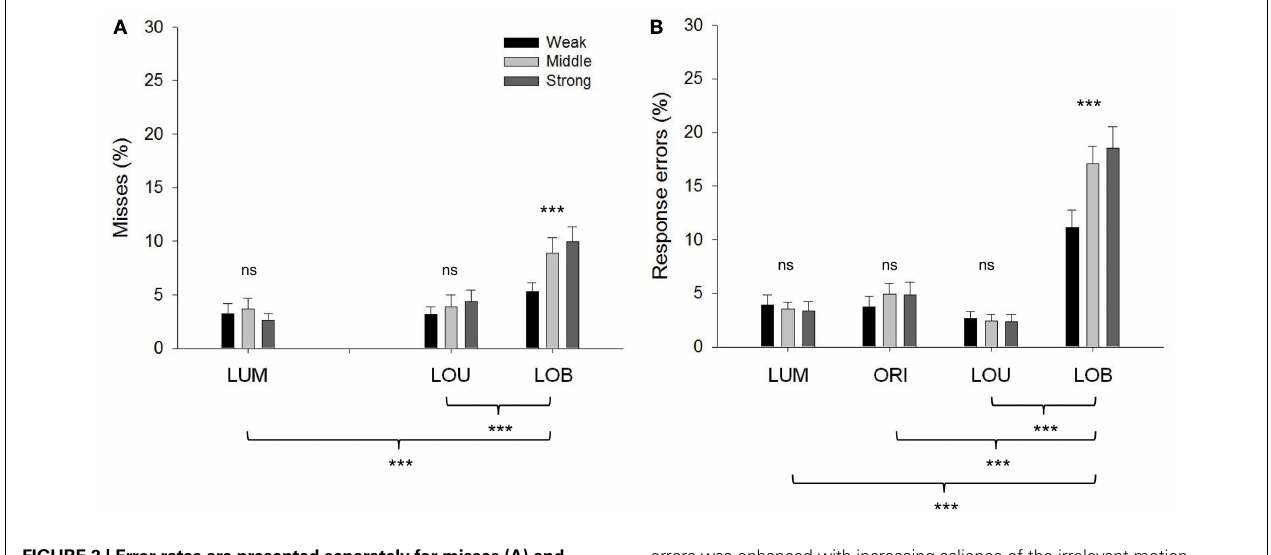
FIGURE 2 | Error rates are presented separately for misses (A) and response errors (B) with error bars depicting the standard error. For both misses and response errors highest rates were shown in the LOB condition. Only in this change condition the rate of misses and response